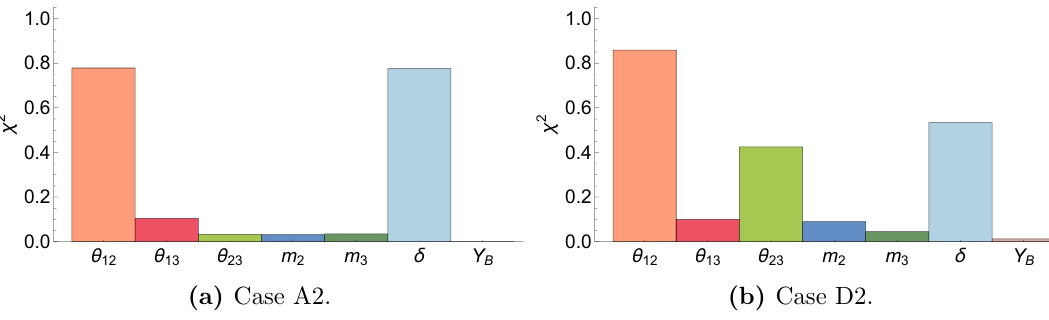
Figure 2 . (cid:31) 2 contribution of each observable for Case A2 and D2 best (cid:12)t